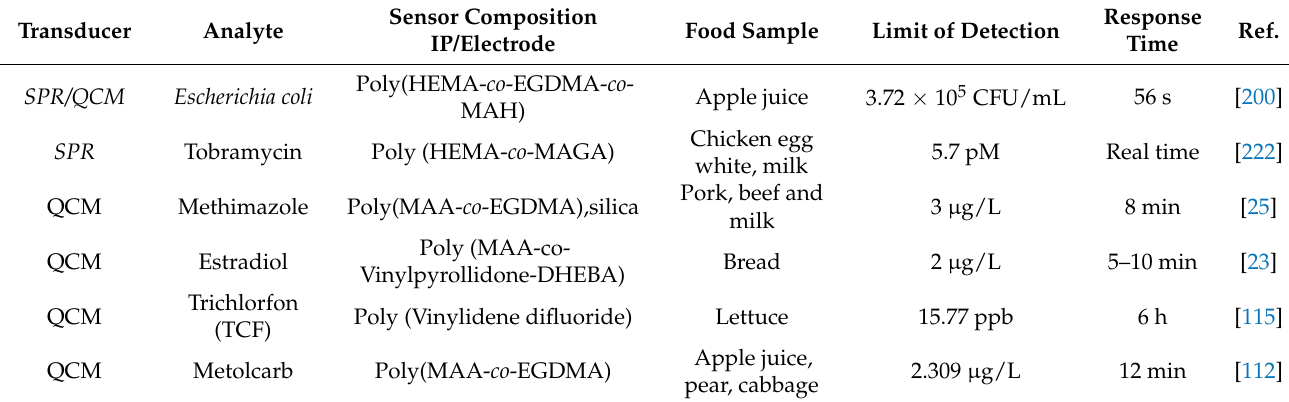
Table 8. Imprinted polymer-piezoelectric sensors for food safety.